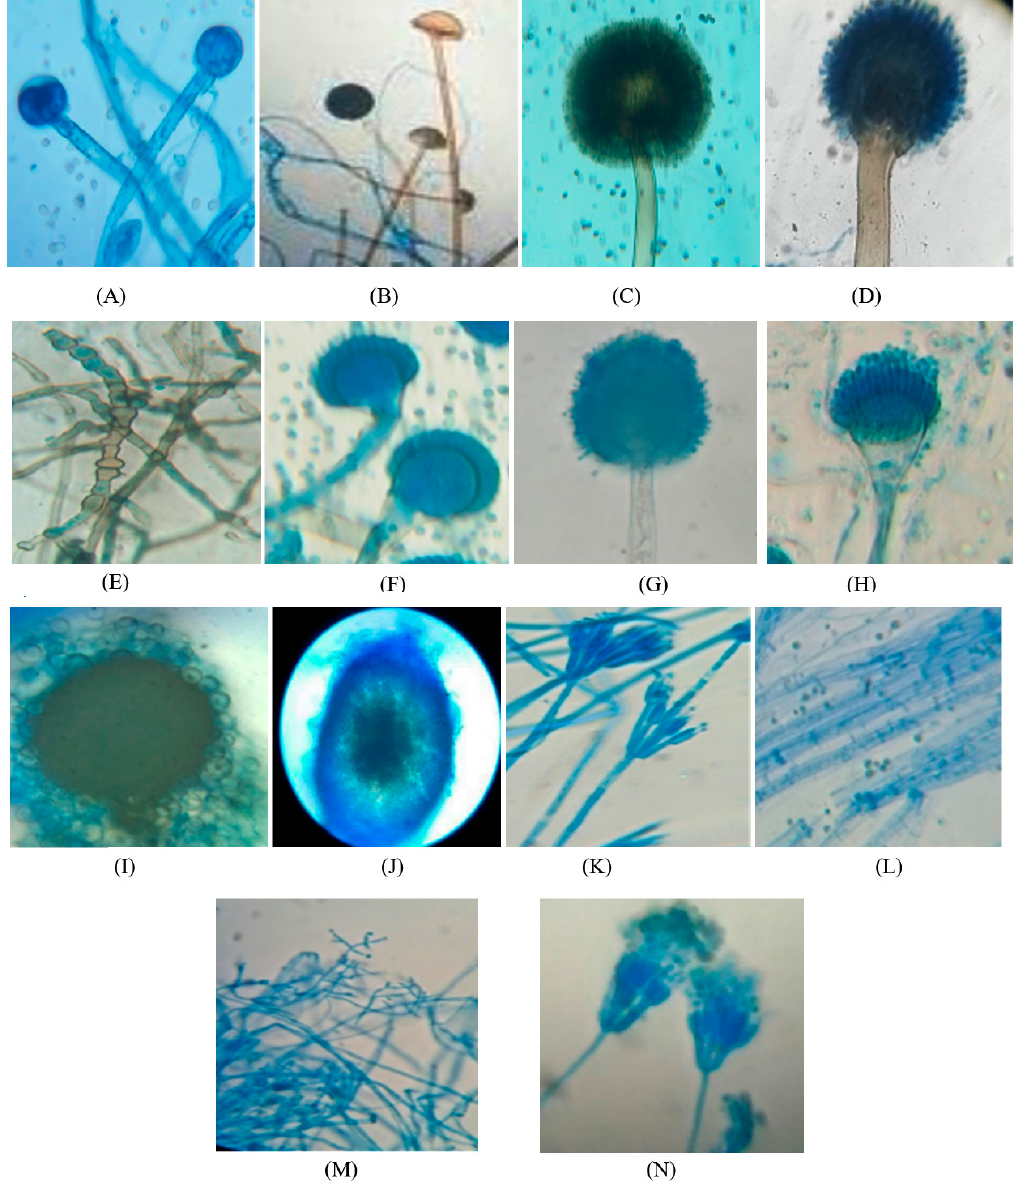
Fig. 5. Schematic diagrams of identified fungal species in order of appearance during the study. A. Mucor hiemalis , B. Rhizopus stolonifer , C. Aspergillus niger , D. Aspergillus japonicus , E. Torula sp . F. Aspergillus nidulans , G. Aspergillus flavus , H. Aspergillus fumigatus , I. Emericella nidulans , J. Ascochyta sp . K. Penicillium chrysogenum , L. Trichoderma reesei , M. Trichoderma viride , N. Penicillium aurantiogriseum